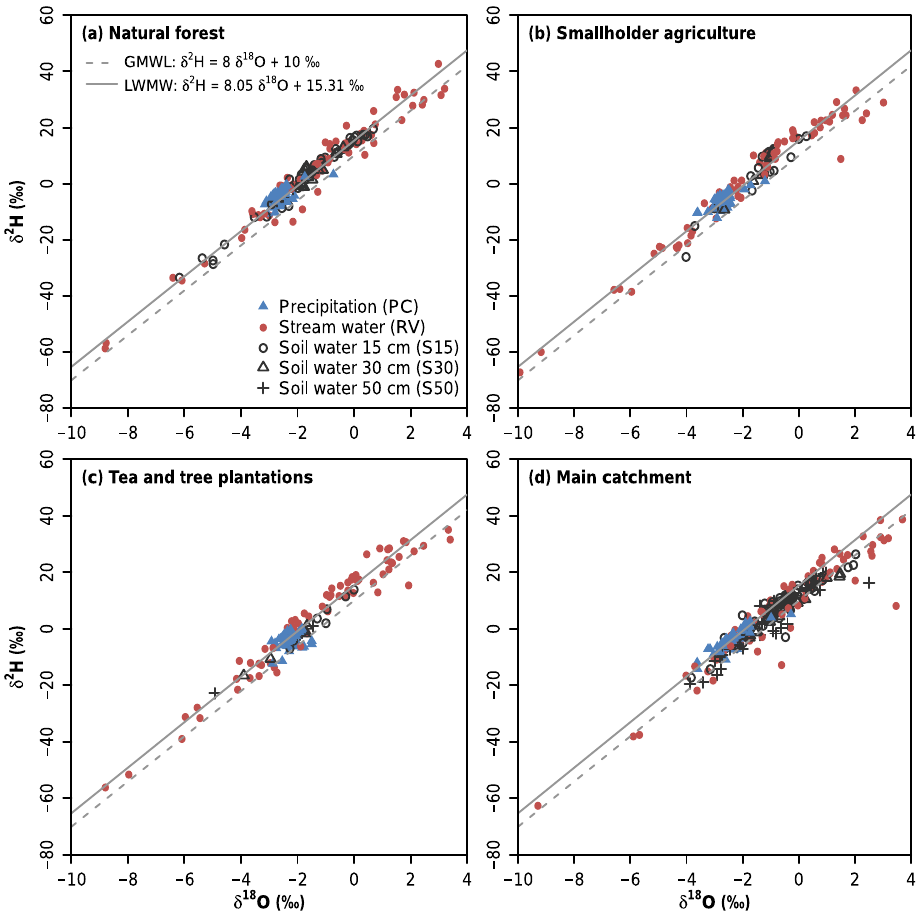
Figure 2. Relationship between δ 18 O and δ 2 H values in precipitation (PC), stream water (RV) and mobile soil water at 15, 30 and 50cm depth (S15, S30 and S50, respectively) for the (a) natural forest (NF), (b) smallholder agriculture (SHA), and (c) tea and tree plantations (TTP) sub-catchments, and (d) the main catchment (OUT) between 15 October 2015 and 17 March 2017 in the South-West Mau, Kenya. The global meteoric water line (GMWL) and local meteoric water line (LMWL) are indicated as dashed and solid lines,